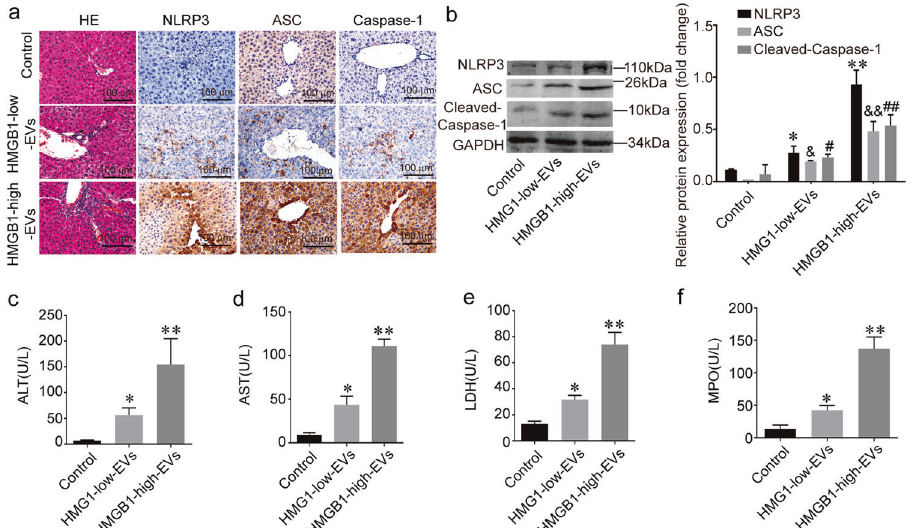
Fig. 8 Serum-derived EVs of patients with sepsis express high HMGB1 and cause liver injury in vivo. a HE and IHC staining of MPO, F4/80, NLRP3, ASC, and Caspase-1 in all groups. n = 5 mice per group. b The NLRP3 in fl ammasome was detected by immunoblotting. c – f The ALT, AST, LDH, and MPO levels. (*) P < 0.05 versus control group. ( & ) P < 0.05 versus control group; ( # ) P < 0.05 versus control group; (**) P < 0.01 versus control group. ( && ) P < 0.01 versus control group; ( ## ) P < 0.01 versus control group. n = 5 mice per